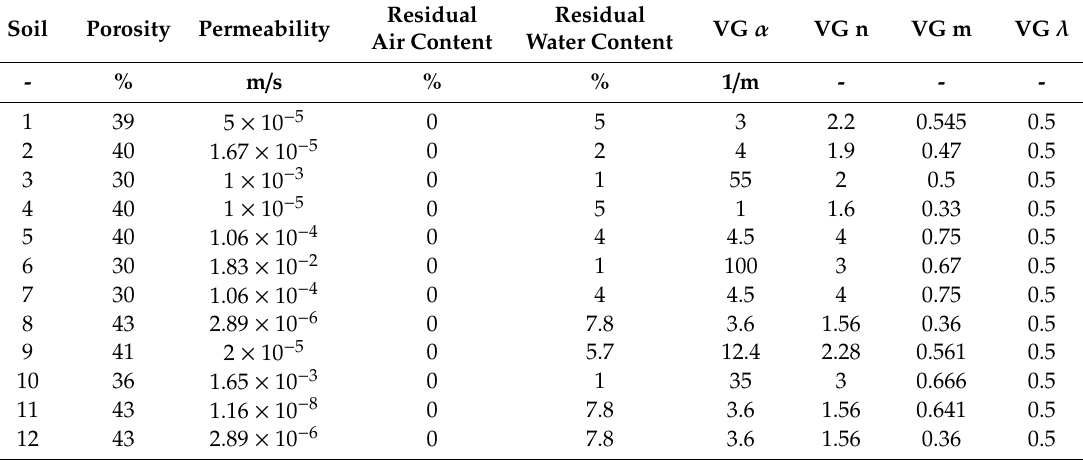
Figure 1. An overview over the shape of models 1 to 6, their sizes and the layout of the soil layers. The colors mistyrose, lightcyan, and darkgoldenrod are reserved for soils. Black depicts a no-flow boundary condition, blue depicts a constant pressure head boundary condition. Red, green, and grey depict a time dependent infiltration rate, darkviolet and brown depict a system dependent boundary condition: As long as the nodes are not saturated, darkviolet and brown nodes depict a no-flow boundary condition, and once the nodes are saturated, the boundary condition switches to a boundary condition with a constant pressure head of 0 m. Orange depicts a time dependent pressure head, olive depicts a seepage face, yellow depicts a constant pressure head and only outflow is allowed in yellow nodes. Table 1. Overview over the parameters of the soils in Figures 1 and